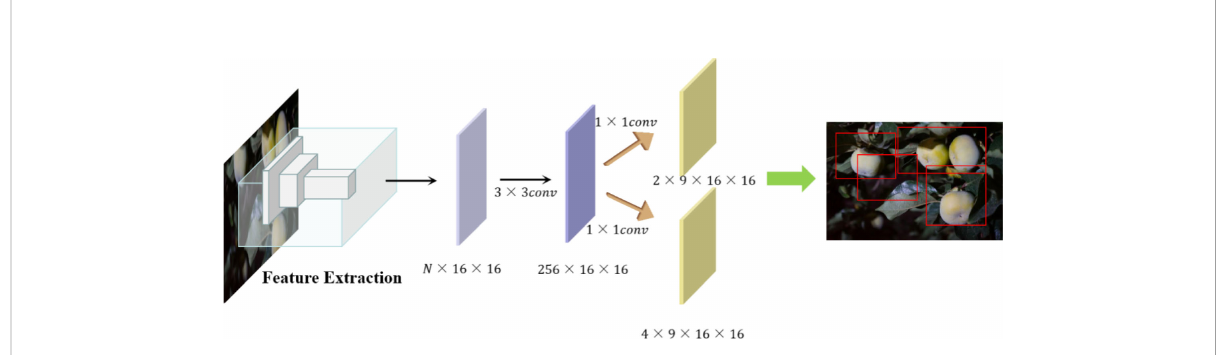
FIGURE 6 RPN structure work fl ow diagram (to generate the fi nal effect of the candidate box for simple and beautiful, selected four candidate boxes).